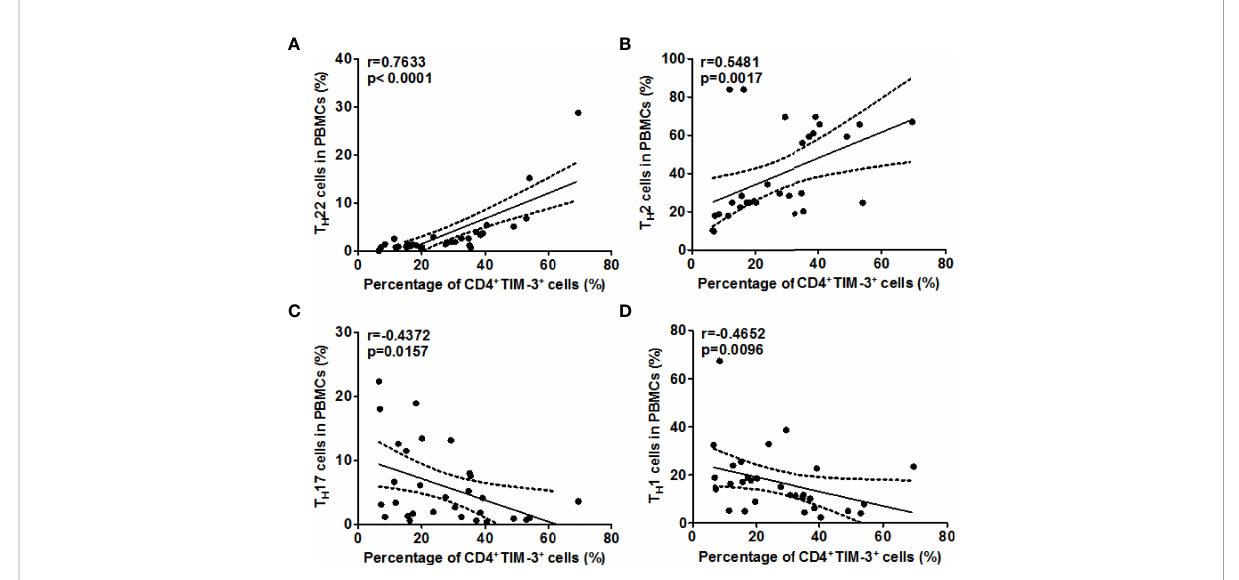
FIGURE 5 The correlation between TIM-3 levels and T H 2/T H 22 as well as T H 1/T H 17 cell ratios in AD. Association between the percentage of TIM-3 + CD4 + T cells and the frequency of T H 1 cells (A) , T H 2 cells (B) , T H 17 cells (C) , and T H 1 cells (D) in patients with AD.